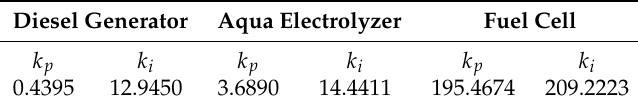
Table 6. The parameters of PI and Fuzzy-PI controller used for simulation.